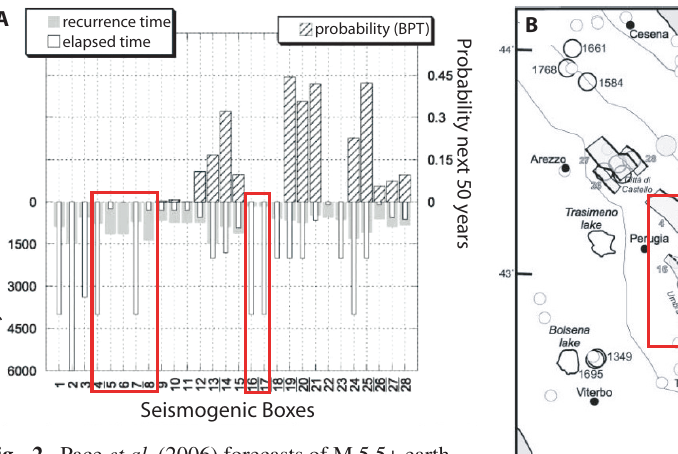
Fig. 2. Pace et al. (2006) forecasts of M 5.5+ earth- quakes in the next 50 years. A) Probabilities, recur- rence times, and elapsed times for each seismogenic structure are reported. B) Map of the seismogenic structures; stars represent the location of Umbria- Marche earthquakes. In both panels, the red boxes mark the Umbria-Marche